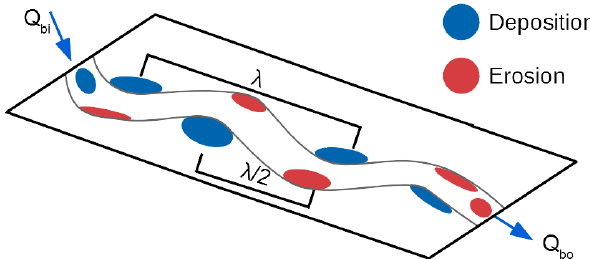
Figure 1. Conceptual basis of the morphologic method. λ corre- sponds to the wavelength between successive zones of deposition, and thus λ/ 2 corresponds to successive zones of deposition and ero- sion. Q bi and Q bo are the input and output discharges of sediment through this